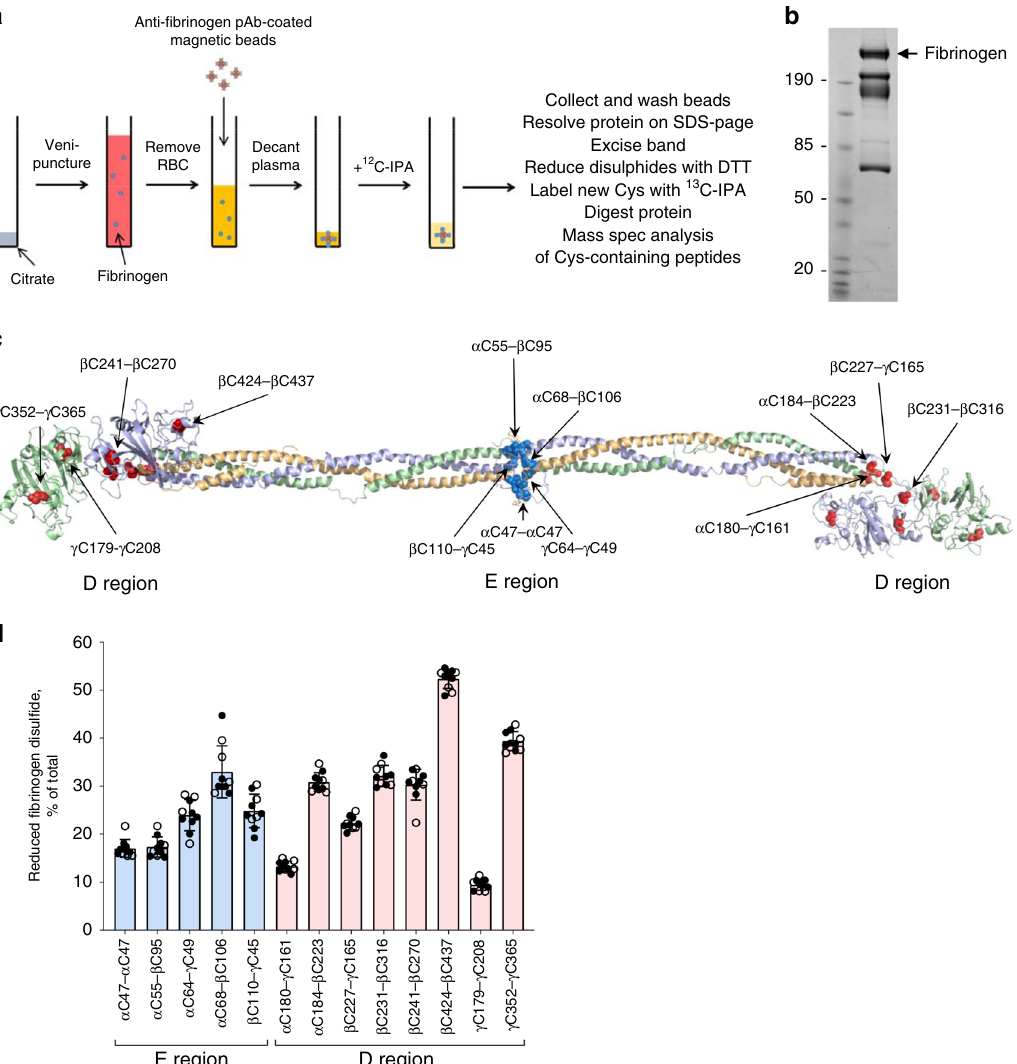
Fig. 1 Fibrinogen exists in multiple disul fi de-bonded states in the circulation. a Blood from healthy donors was drawn by venipuncture into citrate as anti- coagulant, plasma prepared by centrifugation and fi brinogen collected on antibody-coated magnetic beads. The unpaired cysteine thiols in bead-bound fi brinogen was alkylated with 12 C-IPA, the protein resolved on SDS-PAGE and the disul fi de-bonded cysteine thiols alkylated with 13 C-IPA following reduction with DTT. The protein was digested with trypsin, 17 peptides (Table S1) encompassing cysteines representing 13 of the 17 fi brinogen disul fi de bonds were analyzed by HPLC and mass spectrometry and the redox state of the disul fi des quanti fi ed. b Example of 12 C-IPA-labeled fi brinogen resolved on SDS-PAGE. Molecular mass standards are shown in the left-hand lane. Fibrinogen has a molecular mass of 340 kDa. c Ribbon structure of fi brinogen and the positions of the 13 disul fi de bonds (red spheres for the D region disul fi des and cyan spheres for the E region bonds) that were mapped 13 (PDB identi fi er 3ghg). The α -chains are in wheat, β -chains in light blue and γ chains in light green. d Redox states of the fi ve E region and eight D region disul fi des in ten healthy human donors (six female — solid symbols; four male — open symbols). The bars and errors are mean ± SD. Source data are provided as a Source Data fi